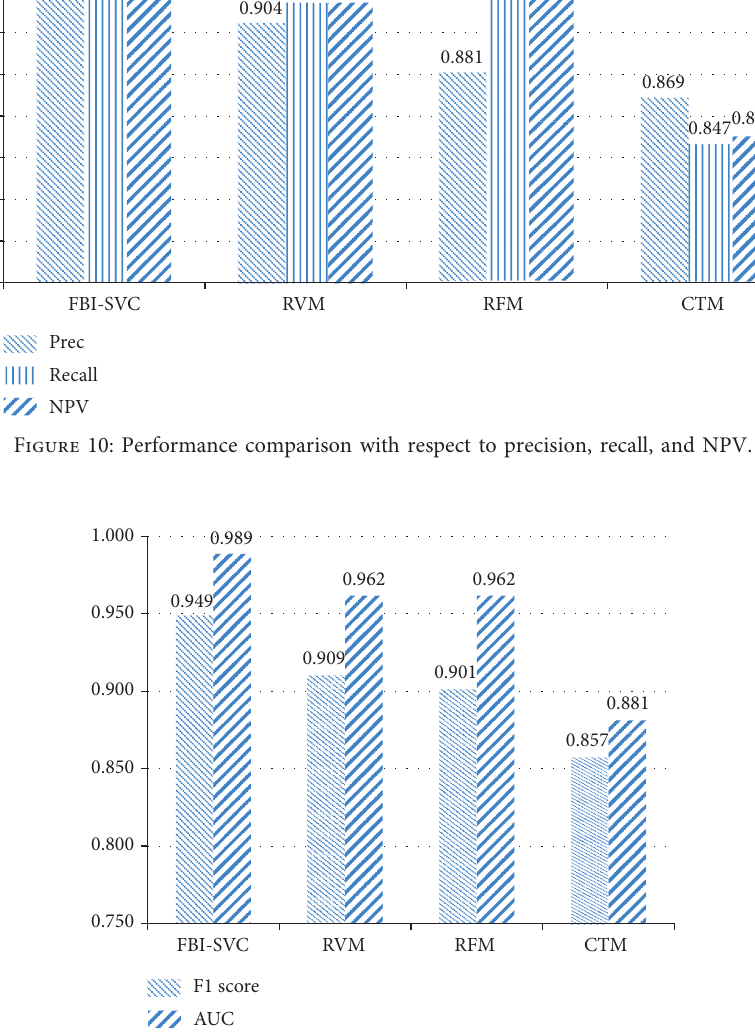
Figure 11: Performance comparison with respect to the F1 score and